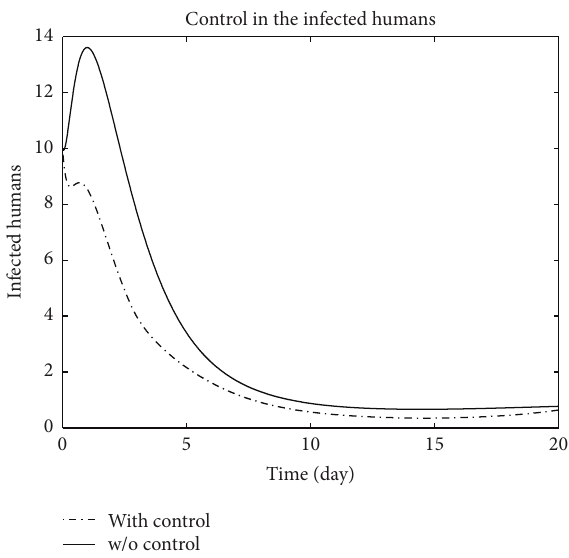
Figure 3: The plot represents the population of infected humans with and without